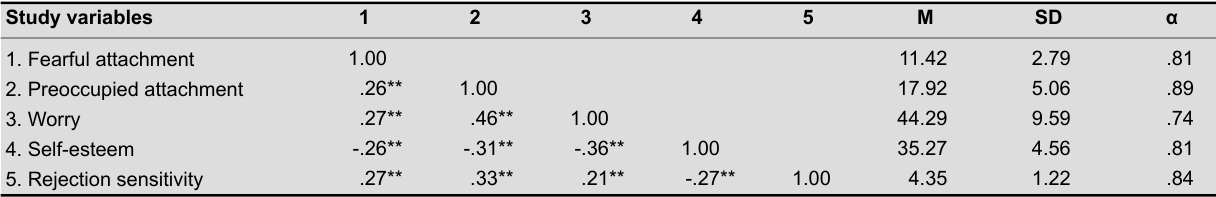
Intercorrelations, Means, Standard Deviations and Consistency Coefficients for Study Variables αSDM54321Study